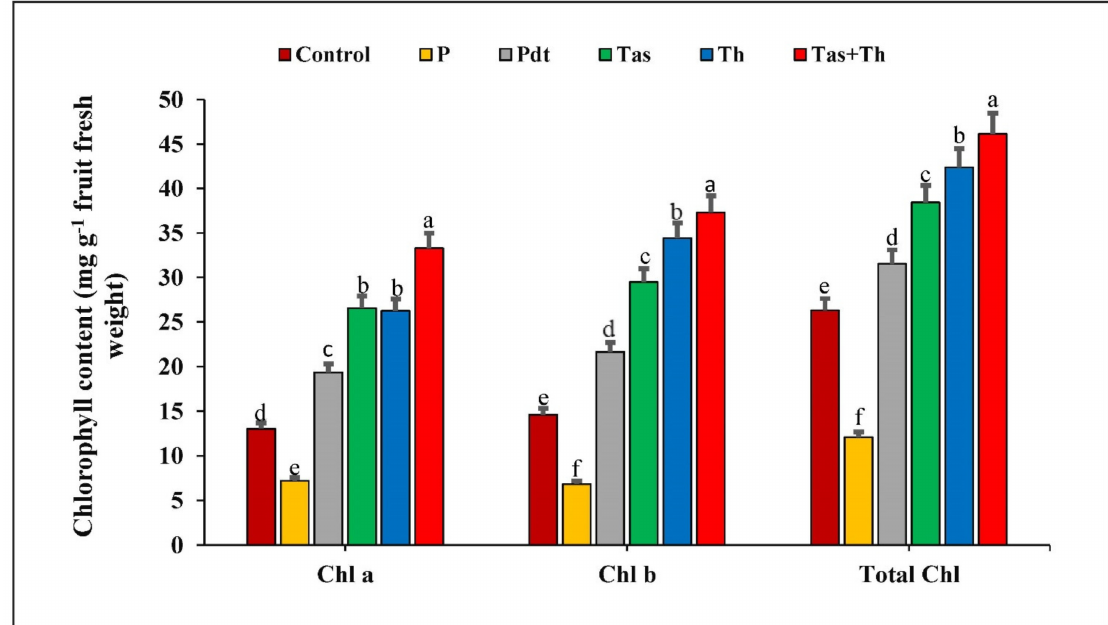
Figure 9. The effect on total chlorophyll, chlorophyll a, and chlorophyll b content in chilli fruits treated with C. truncatum and bioagents (Pdt = P. dendritiformis, Tas = T. asperellum, Th = T. harzianum, and Tas+Th = T. asperellum + T. harzianum ) under a challenged condition and C. truncatum -infected samples after 48 h. Each value is expressed as the mean of triplicates, and the bars sharing the same alphabetical letters are not significantly different ( p ≤ 0.05) using Duncan’s multiple range test. The vertical bar designates the standard